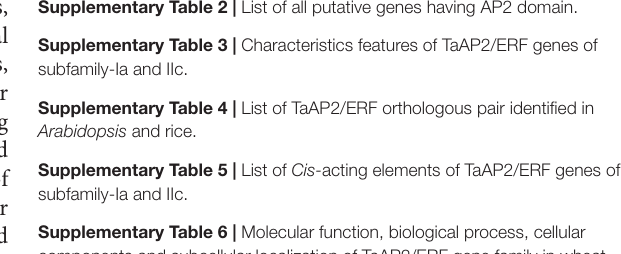
Supplementary Figure 2 | Chromosomal distribution of TaAP2/ERF family genes. Supplementary Table 1 | List of primers used in qRT-PCR analysis. Supplementary Table 2 | List of all putative genes having AP2